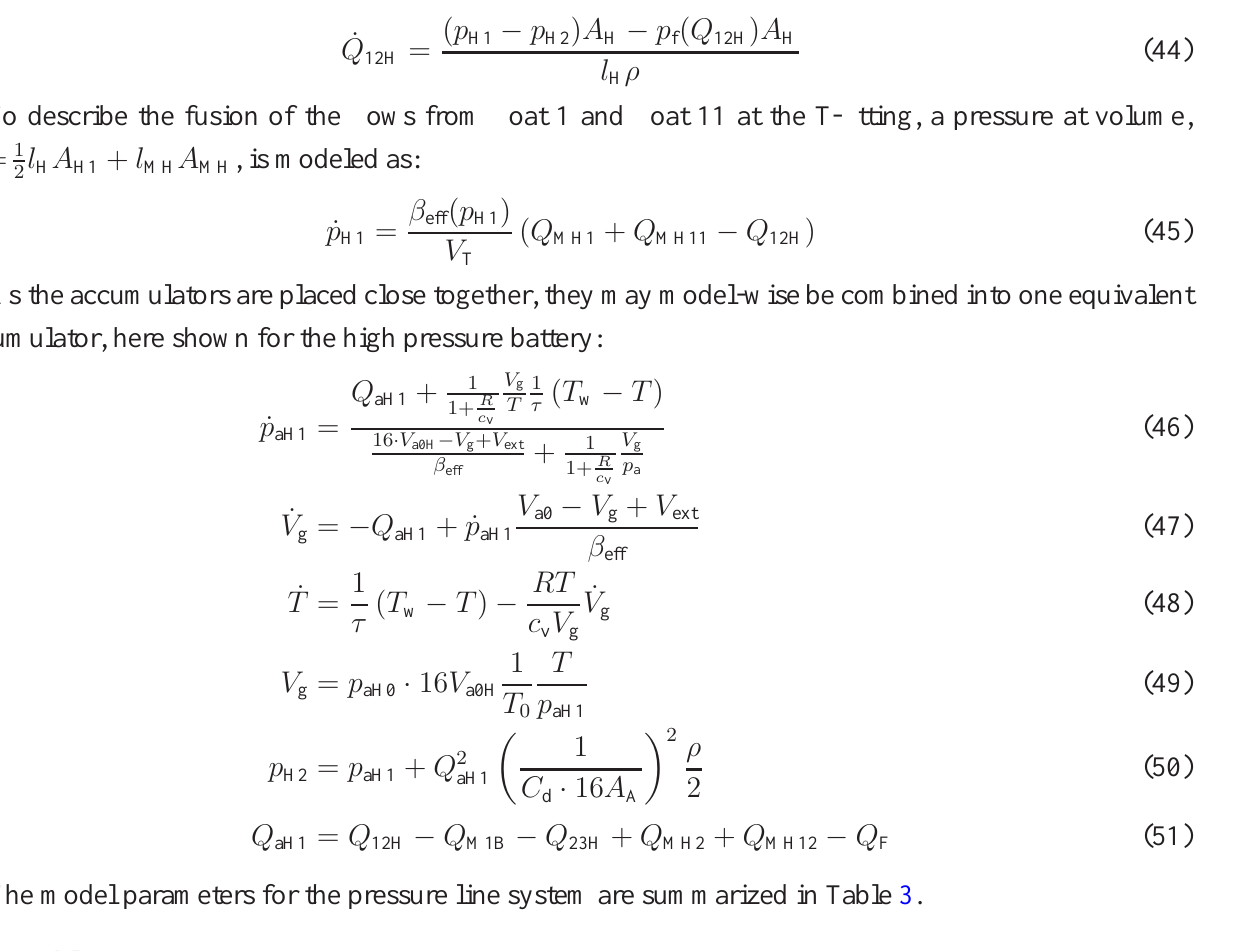
Table 3. Parameter values used for the pressure line system, where “Par.” and